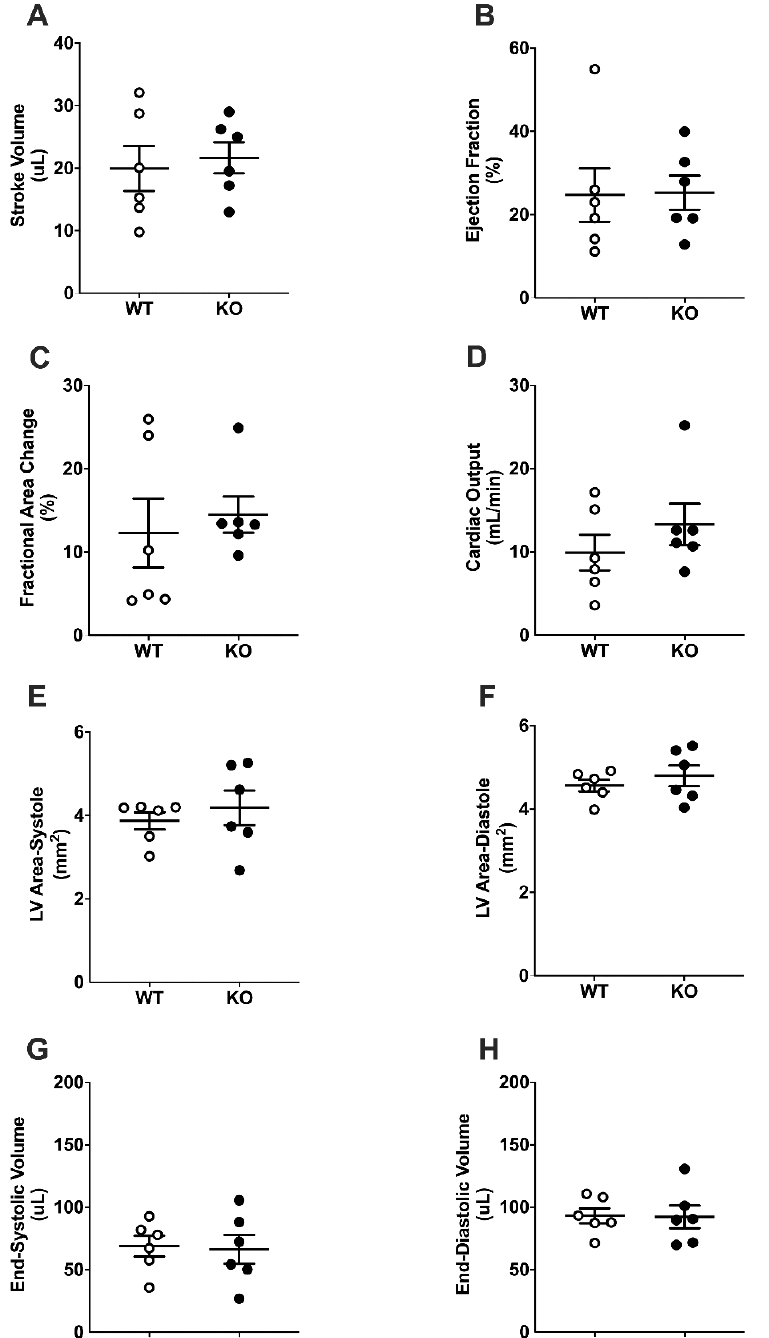
Figure 5. Cardiac dimensions and function following myocardial infarction (MI). SV ( A ), EF ( B ), FAC ( C ), CO ( D ), left ventricular systolic ( E ) and diastolic ( F ) areas, ESV ( G ) and EDV ( H ) in WT (white, n = 6) and KO (black, n = 6) female mice 7 days and 14 days following chronic LAD ligation. Student’s t-test. Data are mean ± SEM.